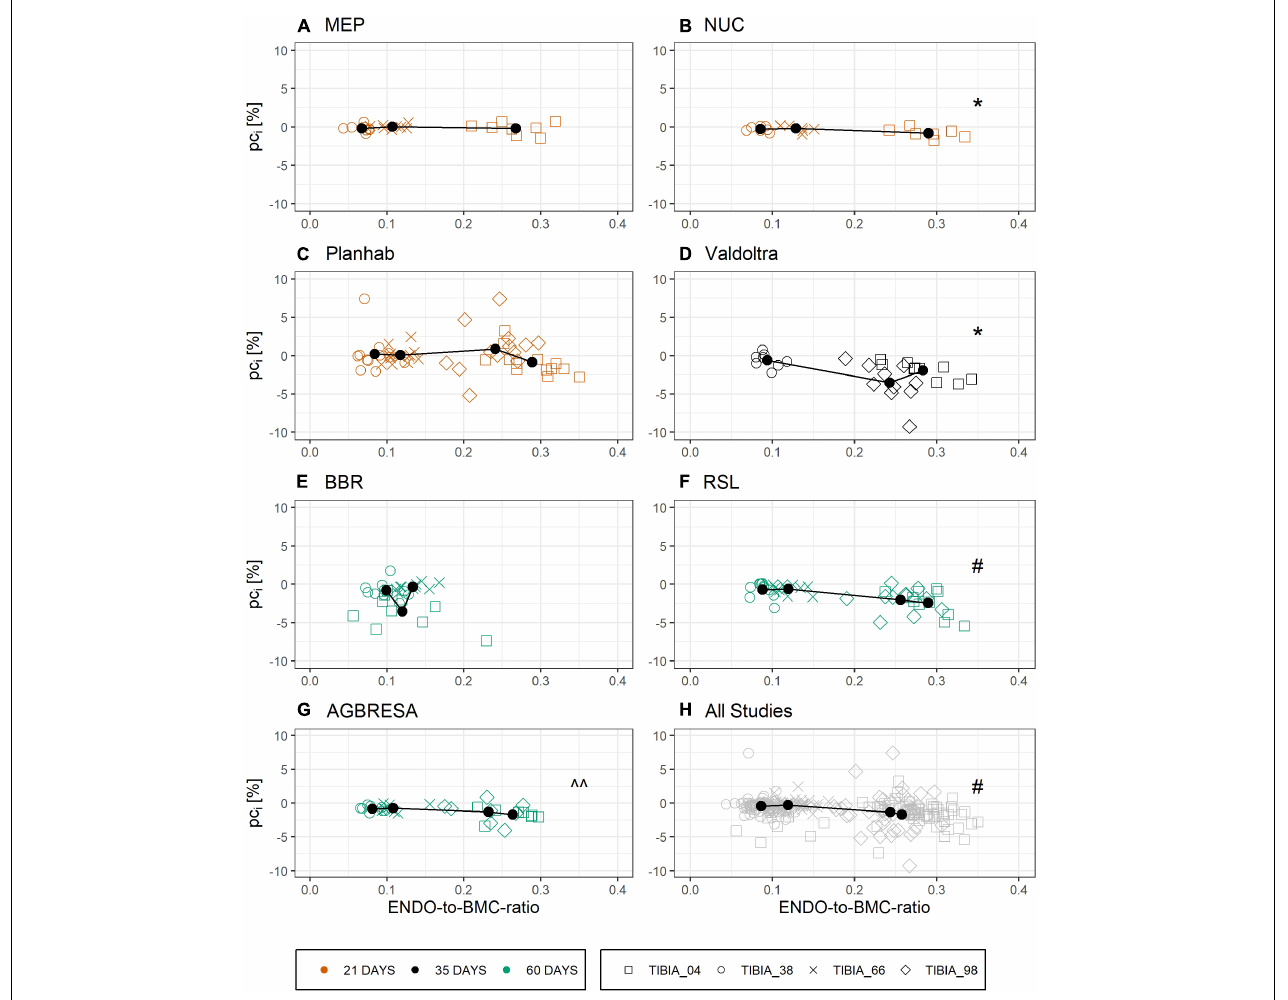
FIGURE 7 | Linear relationship of ENDO-to-BMC-ratio at baseline and the individual pc i by study with (A) MEP, (B) NUC, (C) Planhab, (D) Valdoltra, (E) BBR, (F) RSL, (G) AGBRESA, and (H) all studies. The color indicates the bed rest duration and the shape represents the measurement site. Numbers in the measurement site names indicate the relative measurement position regarding the entire tibia length from distal to proximal. Presented are studies with at least three out of four bone sites. Black points are the mean value of each measurement site. Linear regression analysis showed significant associations across the different studies except for BBR, MEP, and Planhab. ˆˆ denotes significant relationship with p < 0.05; * denotes significant relationship with p < 0.01; # denotes significant relationship with p <